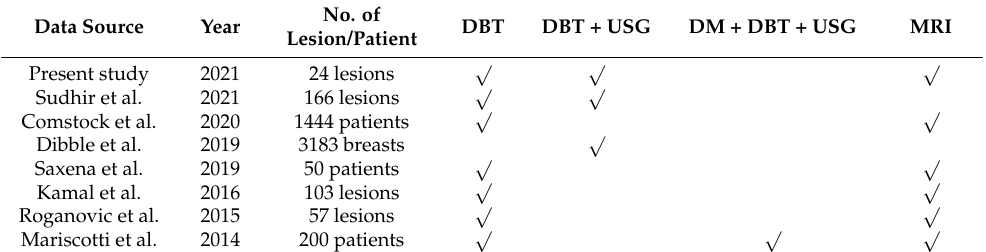
Table 6. Comparison in components of the present study with other